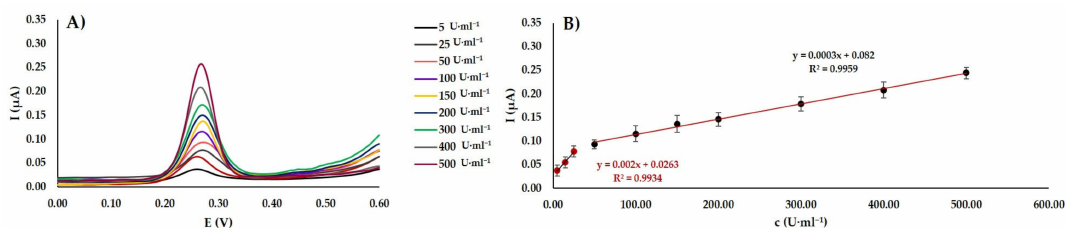
Figure 6. Analysis of methyltransferase activity by DPV in undiluted serum samples. ( A ) The voltammograms of the modified WEs by ssDNA − 1 / dsDNA-2 / rGO-AuNPs were then methylated by various concentrations of M.SssI Mtase. ( B ) The calibration curve showing the correlation between an electrochemical current response and concentration of M.SssI MTase. The error bars are represented using the RSD% of measurements ( n =